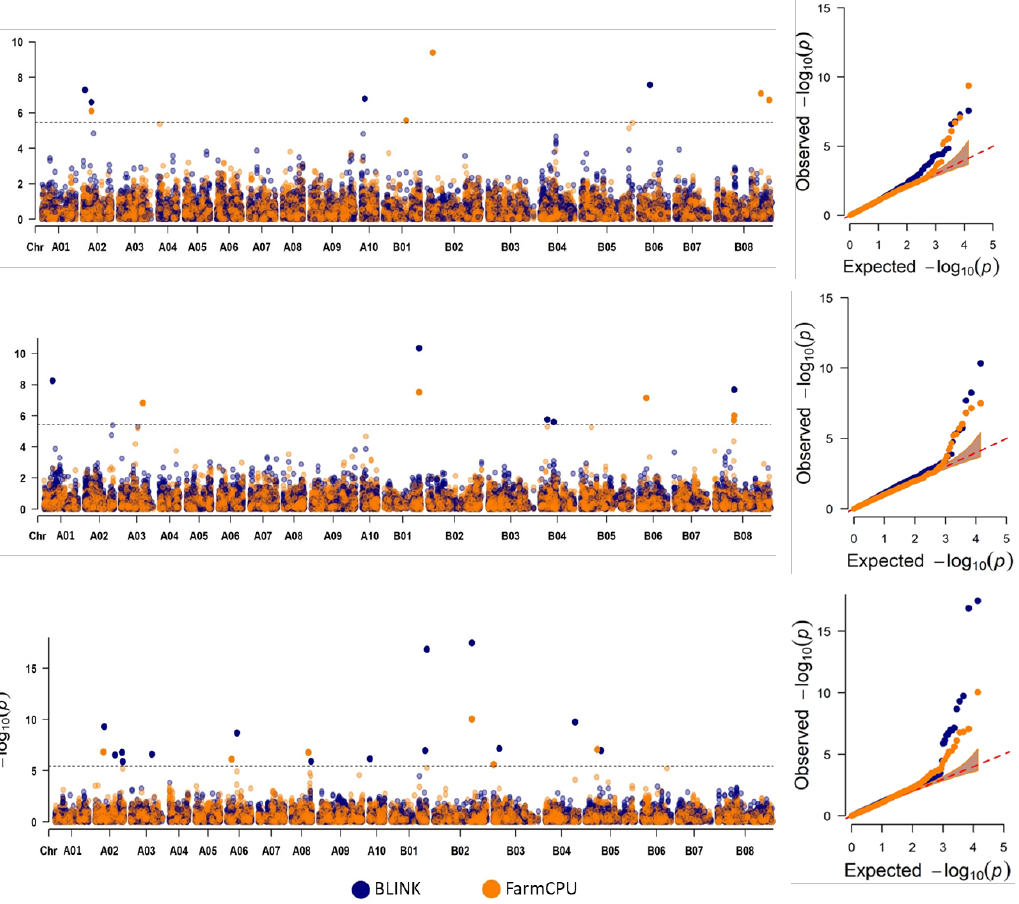
Figure 3. Manhattan and q-q plots for the GWAS of ( a ) total GSLs, ( b ) sinigrin and ( c ) gluconapin using BLINK (purple dots) and FarmCPU (orange dots) models. The horizontal line represents significance threshold at 5% after Bonferroni multiple test correction ( − log10 ( p ) = 5.45). 2.5. Significant GWAS Hits Had Known and Potential GSL Genes in Their Vicinity The LD decay plot based on 14,125 SNPs suggested no effective LD (threshold of r 2 = 0.1) at distances above 500 kb (Figure S4); hence, the search for potential candidate genes (using the B. juncea var. tumida V1.5 annotation) proximal to the trait-associated SNPs was limited to 250 kb upstream and downstream of the SNP position. Based on their homology with Arabidopsis genes and respective annotation, candidate genes were classified as known or potential GSL genes (Table 1).